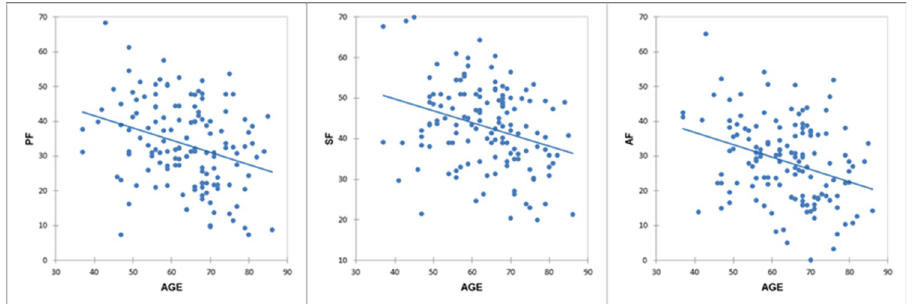
Fig 1. Correlations between age and fluency tests scores. Age and phonemic fluency (r = − 0.31, p = 0.0002); age and semantic fluency (r = − 0.3, p = 0.0003); age and alternate fluency (r = − 0.32, p < 0.0001). PF , Phonemic Fluency; SF , Semantic Fluency; AF , Alternate Fluency.